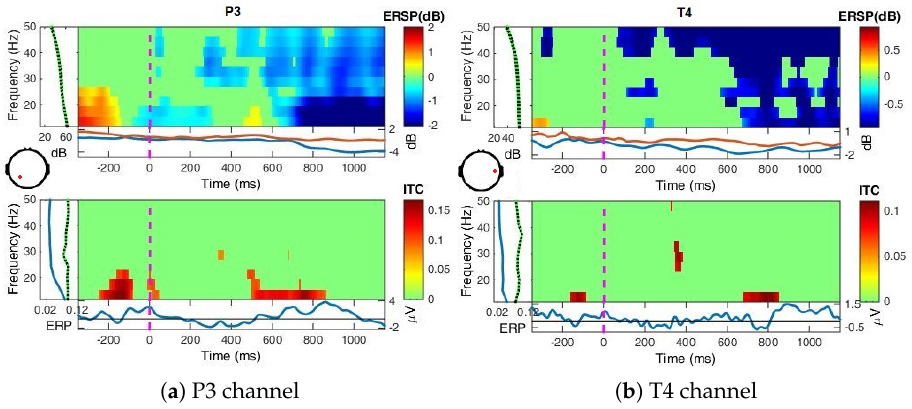
Figure A5. ERSP over all blocks for Nat perception at P3 and T4, bootstrap significance level α = 0.01. Frac perception (Figure A6): For fractal perception, the strong desynchronizations continue until 30 Hz for P3, after 600 ms, and until 20 Hz for T4 after 600 ms. Synchroniza- tion is also observed for T4 at 250–450 ms in the β band (20–30 Hz), effect significant as detected by bootstrap statistics at 0.01 confidence